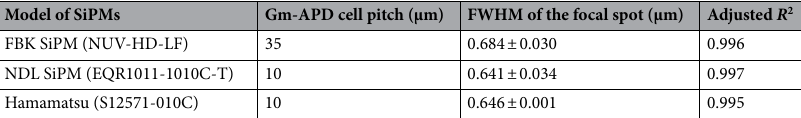
Table 2. Fitting parameters of the focal spot under test.